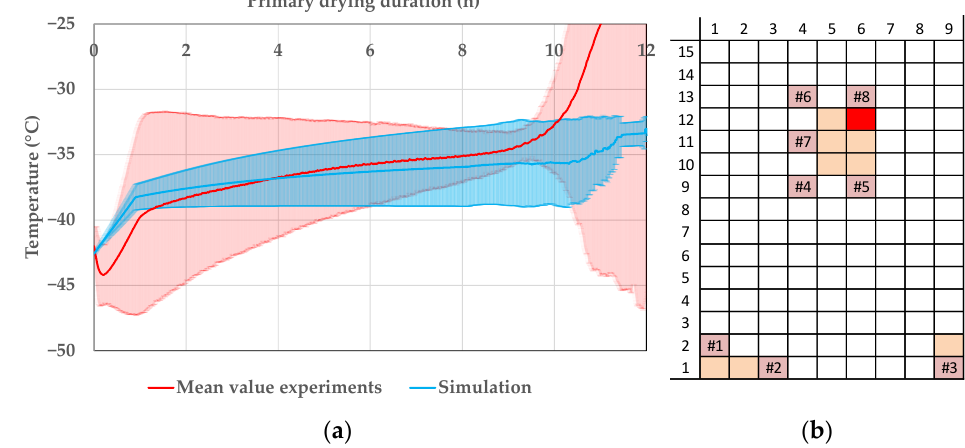
Figure 14. ( a ) Product temperature profile of vial 12.6 during primary drying at the CP. ( b ) Vial position (red: shown vial, orange: other probed vials, pink: WTMplus sensor position and WTMplus number).